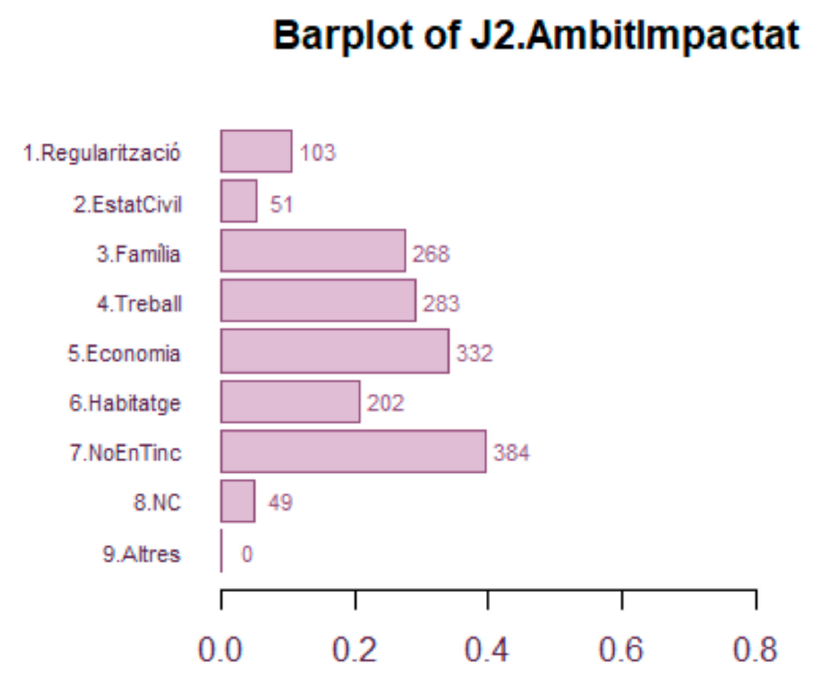
Figure 8. Marginal bar plot of J2